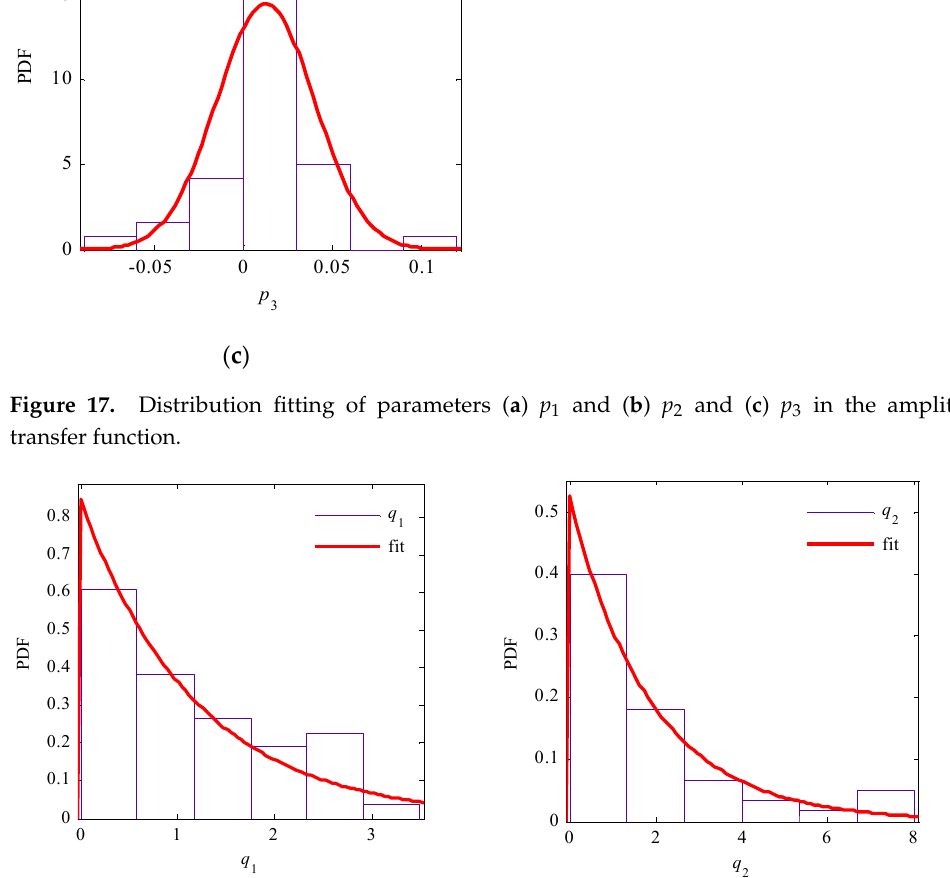
Figure 17. Distribution fitting of parameters ( a ) p 1 and ( b ) p 2 and ( c ) p 3 in the amplitude transfer function. Table 1. Probability distribution of parameters in the amplitude and phase transfer functions.